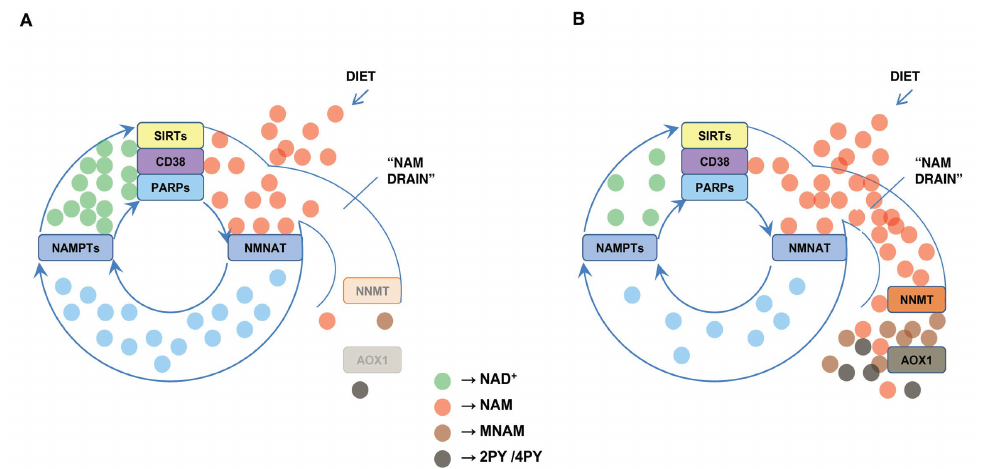
Figure 2. “NAM drain”-mediated NAD + decrease. ( A ) Under physiological conditions in young, healthy, non-obese people, most of the nicotinamide (NAM) generated in NAD + -consuming reac- tions is recycled to NAD + in the salvage pathway due to low expression of NNMT and AOX1 in adipose tissue. ( B ) In the elderly, obese and people with diabetes, cardiovascular, pulmonary and renal diseases, highly expressed and activated NNMT and AOX1 exclude NAM from the salvage pathway. This “NAM drain” facilitates NAD + depletion, particularly in stress conditions such as SARS-CoV-2 infection.